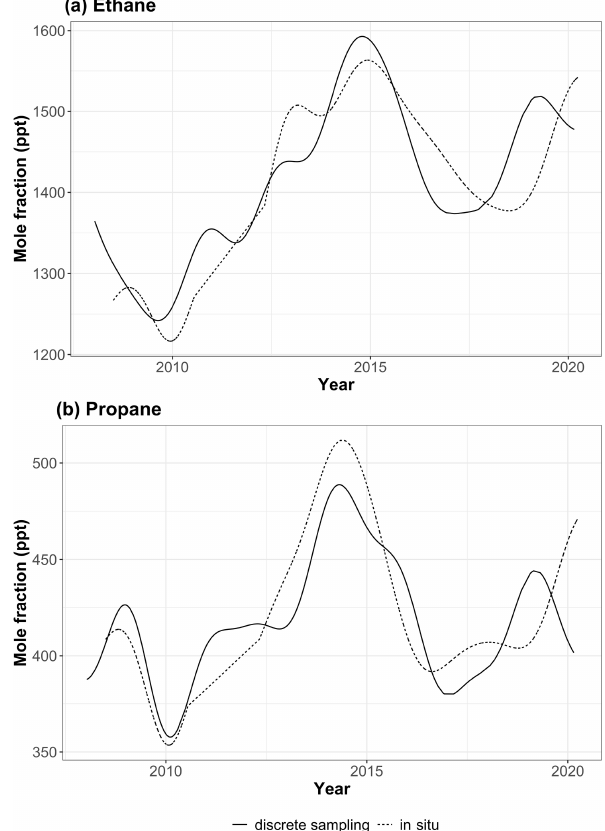
Figure 4. (a) Ethane and (b) propane trends at GEOSummit from July 2008 to March 2020. Trends inferred from in situ and discrete flask sampling are shown by the dotted and solid lines,